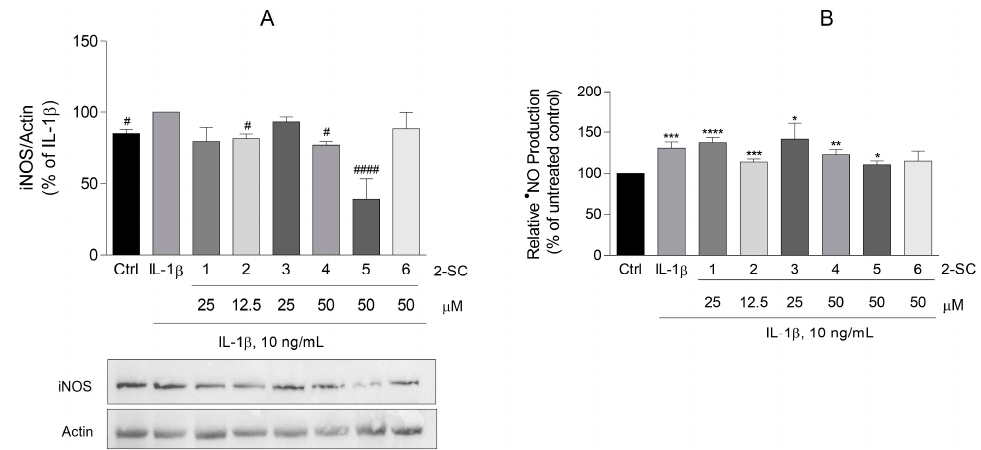
Figure 3. Effect of 2-Styrylchromones (2-SC) on IL-1 β -induced inducible nitric oxide synthase (iNOS) protein expression ( A ) and nitric oxide ( • NO) production ( B ) in human fibroblast-like synoviocytes (HFLS). Cell cultures were left untreated (control, Ctrl) or treated with IL-1 β (10 ng/mL), for 24 h, following pre-treatment for 30 min with the indicated concentrations of the 2-SC. Each column represents the mean ± SEM of, at least, 3 independent experiments. * p < 0.05, ** p < 0.01, *** p <